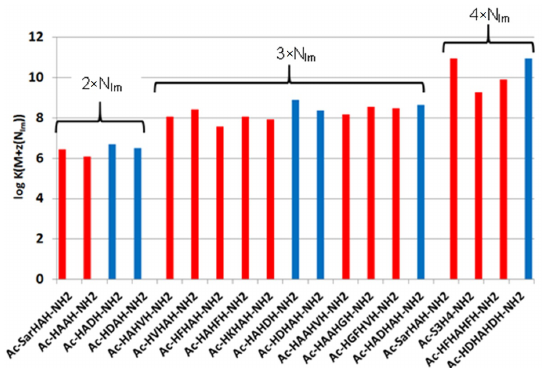
Figure 1. Equilibrium constants of imidazole-coordinated copper(II) complexes (log K (M + z(N Im ))) of various histidine-containing peptides (data from refs. [8,9,13]); ( ■ ) data-related complexes of peptides containing aspartic acid.